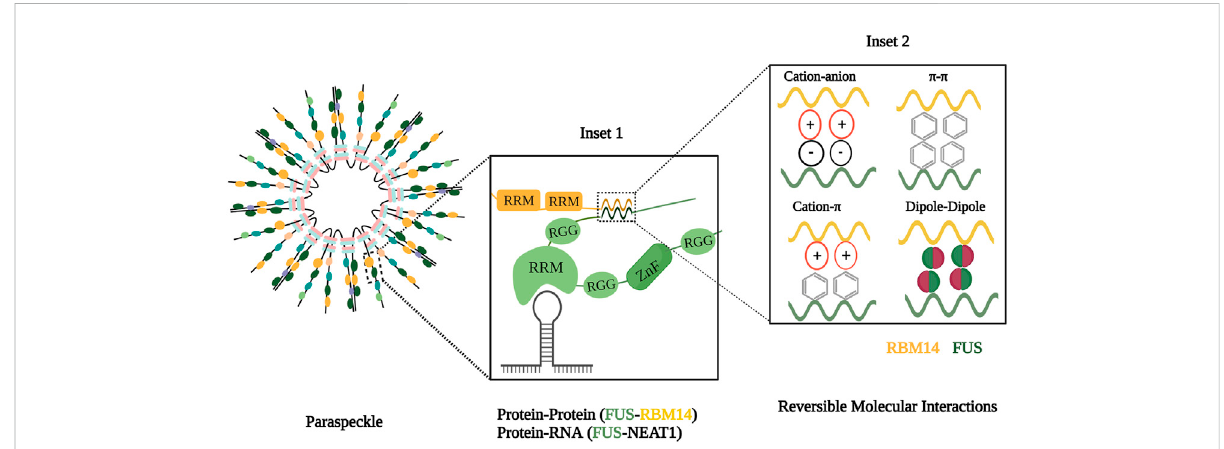
FIGURE 1 Molecular components and forces involved in condensate formation. Inset 1 illustrates the assembly of paraspeckle comprising scaffolds and clients and interactions between these components. Inset 2 depicts molecular forces with in inter and intramolecular interactions with in phase